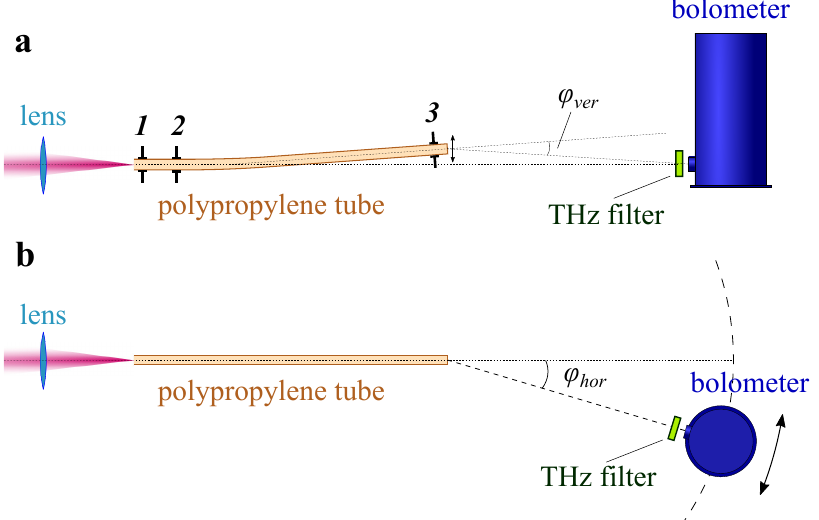
Figure 1. Scheme of the experiment: ( a ) side view; ( b ) view from above. 1–3–mounts fixing the